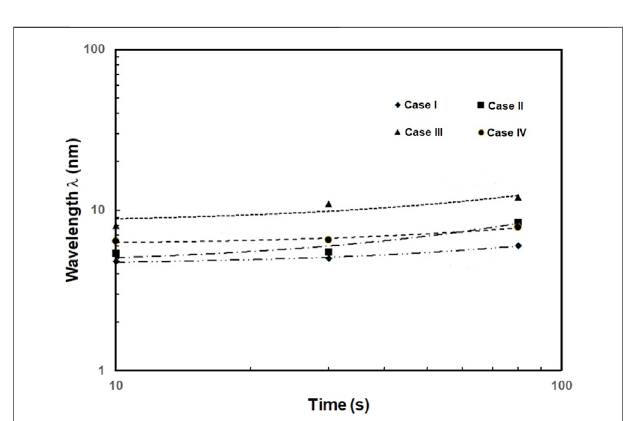
FIGURE 13 | Plot of modulation wavelength λ versus time t for the present study cases.